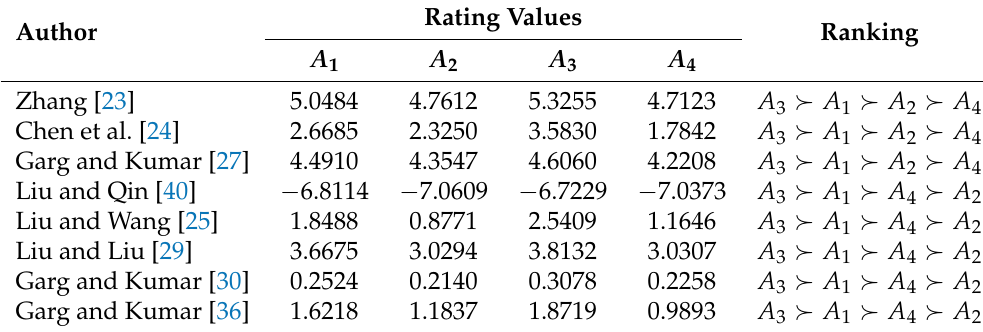
Table 8. Comparison with existing